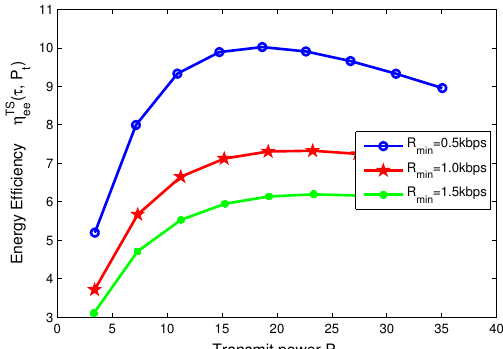
Figure 15. Energy efficiency versus transmit power with different minimum QoS requirements for TS mode.